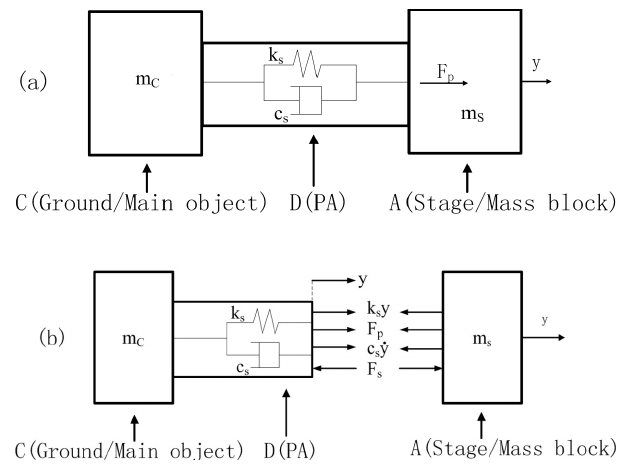
Figure 5. The spring-mass-damping system: (a) total system of the PA and A (stage/mass block) and (b) force analysis of the PA and A (stage/mass block) (Adriaens et al.,